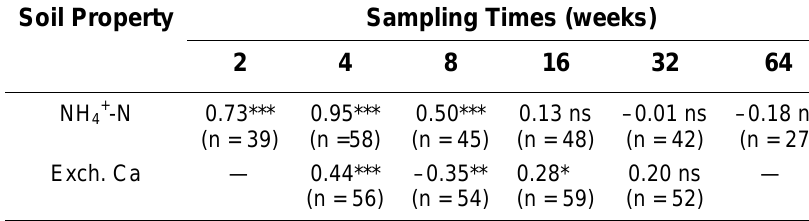
Correlation Between pH and Some Soil Properties Monitored During Incubation of a Tropical Soil Treated with GMs Alone or in Combination with Inorganic P